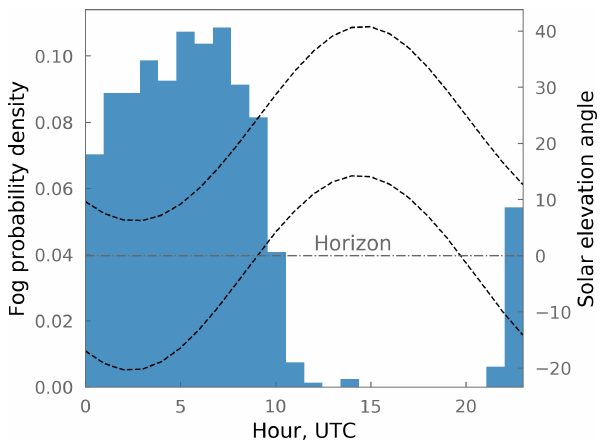
Figure 2. Diurnal distribution of fog during the summer 2019 case studies listed in Table 3 (blue bars). Black dashed lines show the maximum and minimum solar elevation angles (June– September 2019). Local time at Summit is UTC −